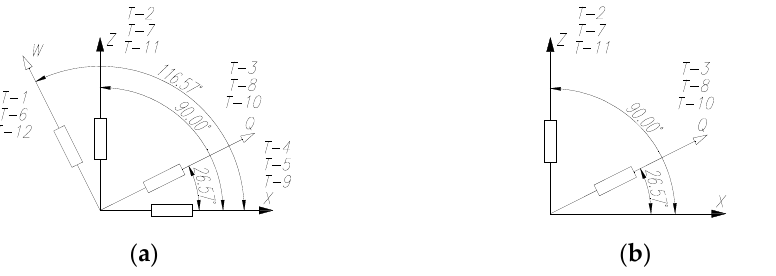
Figure 10. Strain gauge arrangement in the strain gauge ring: ( a ) layout 1 and ( b ) layout 2.